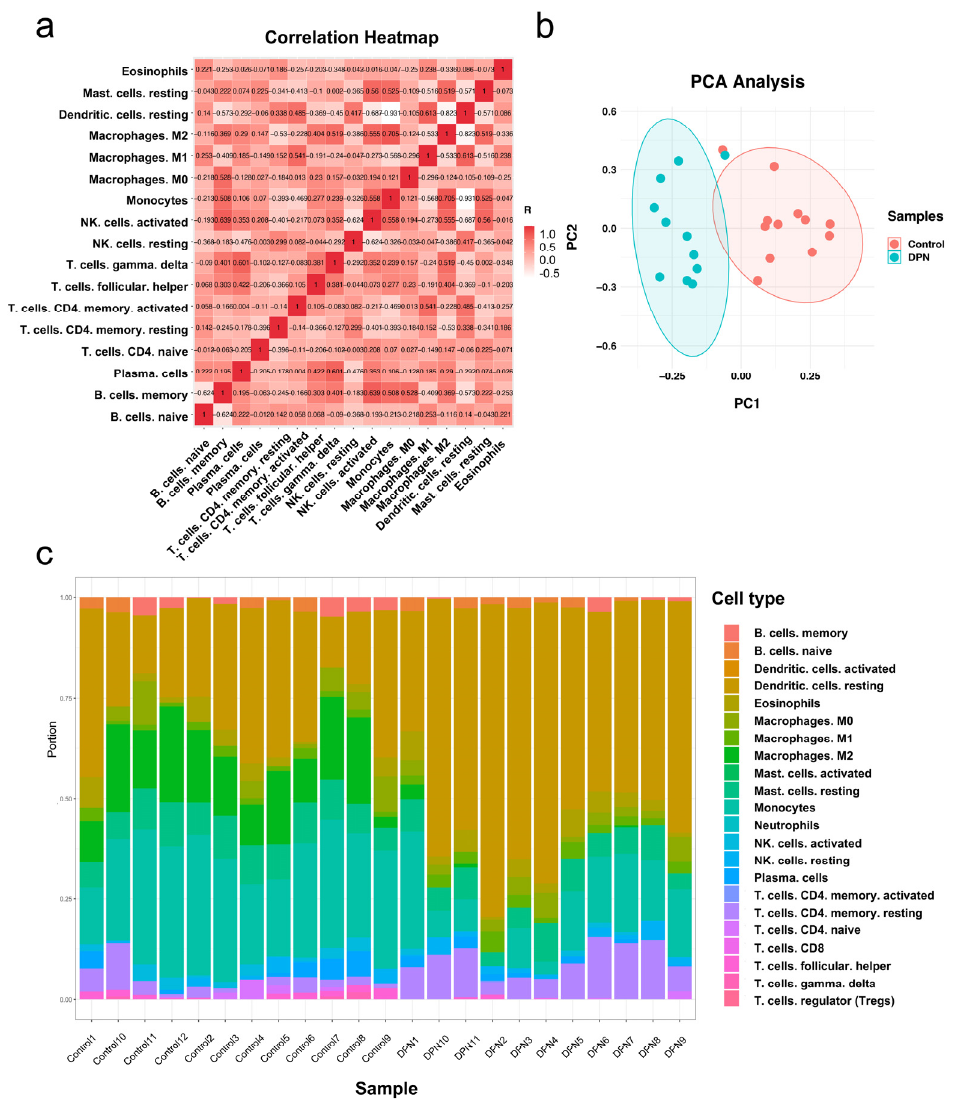
Figure 5. Evaluation and visualization of immune cell infiltration in DPN and normal samples. ( a ) The correlation of immune cells in DPN samples was evaluated. Different shades of squares represent the degree of negative or positive correlation. ( b ) Principal component analysis (PCA) cluster plot of immune cell infiltration between DPN and normal samples. ( c ) A histogram plot shows the composition of immune cells in each sample.